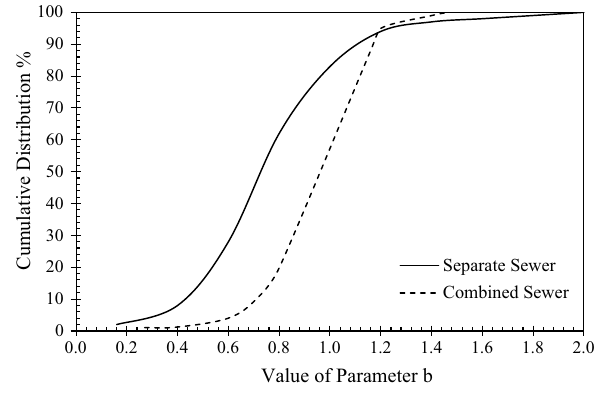
Fig. 3 Cumulative distribution of parameter b for the M curves for TSS (Bertrand-Krajewski et al.